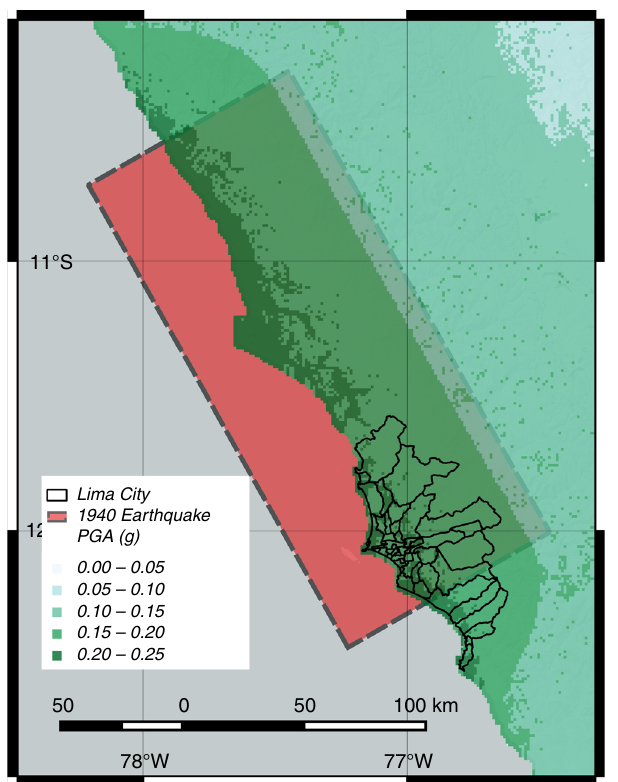
Fig. 2 Casualty scenario for M 8.0 earthquake occurring at nighttime in Lima. The plot shows the spatial distribution in km 2 of the mean number of earthquake injuries requiring surgical procedures after the M 8.0 seismic event. The intervals represent quantiles (20th-percentile increments) on the spatial data. Source data are provided as a Source Data fi le, and the base map layer is available under a https://www.openstreetmap.org/